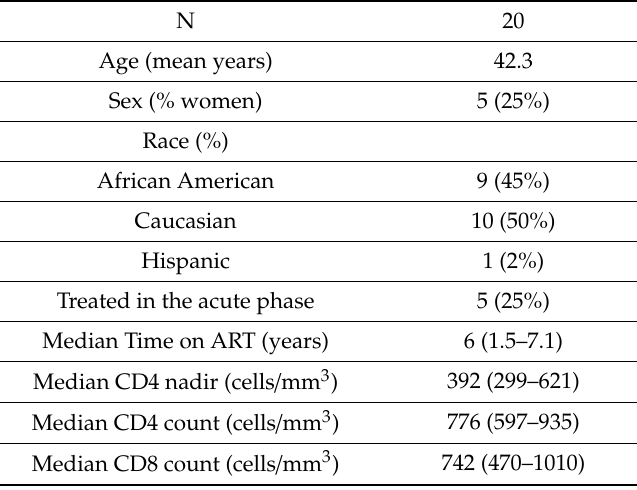
Table 1. Characteristics of PLWH on stable and suppressed